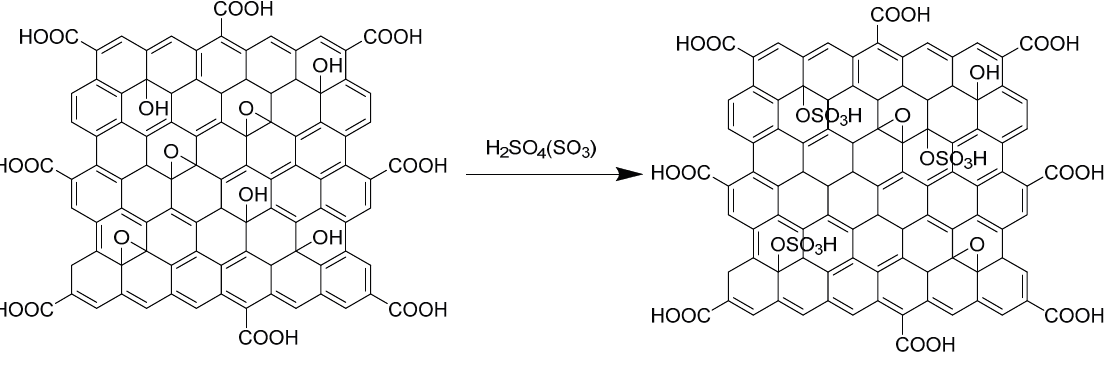
Figure 14. Synthetic Route to sulfated graphene oxide GO-OSO 3 H. Reprinted with permission from [97]. Copyright 2012 American Chemical